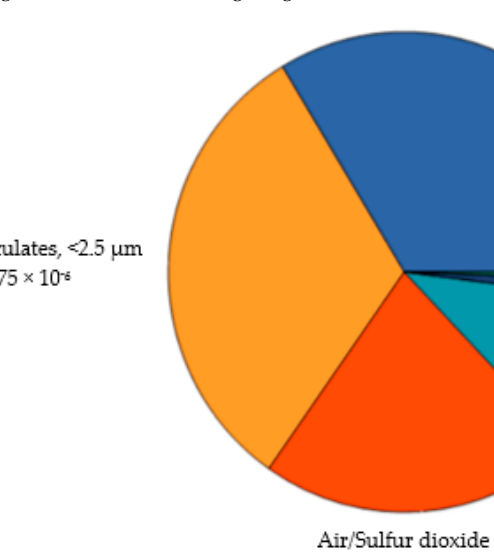
Figure 6. Emissions contributed to the ‘Climate Change Human Health’ impact category (damage assessment / excluding long-term emissions).